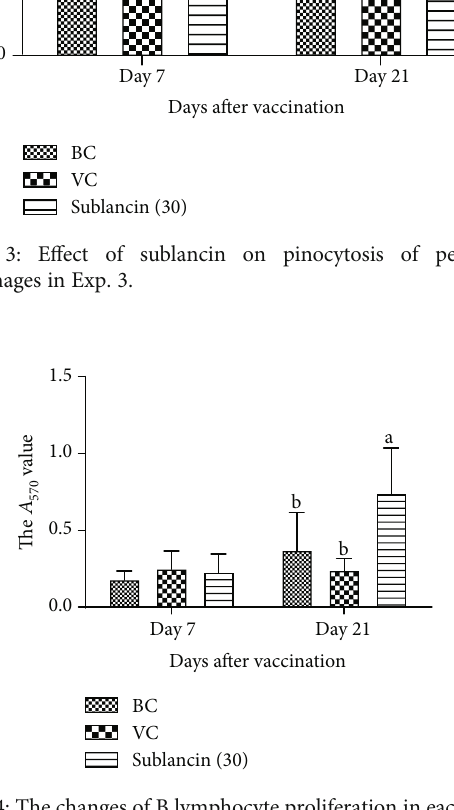
Figure 4: The changes of B lymphocyte proliferation in each group in Exp. 3. a,b Bars in the same day without the same superscripts di ff er signi fi cantly ( P < 0 : 05